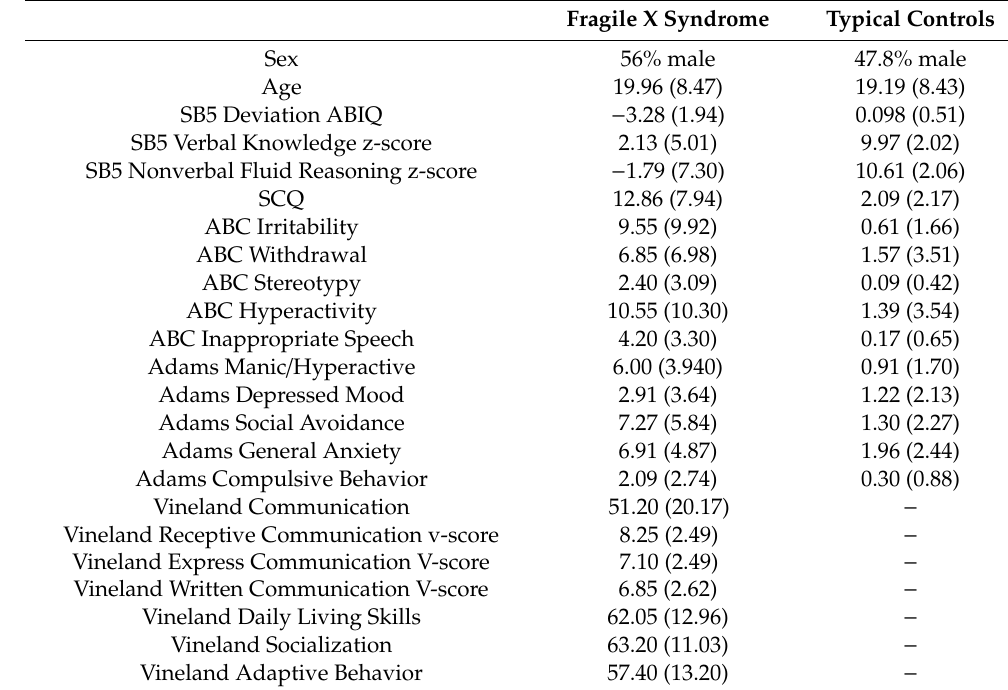
Table 1. Demographic and measure means.